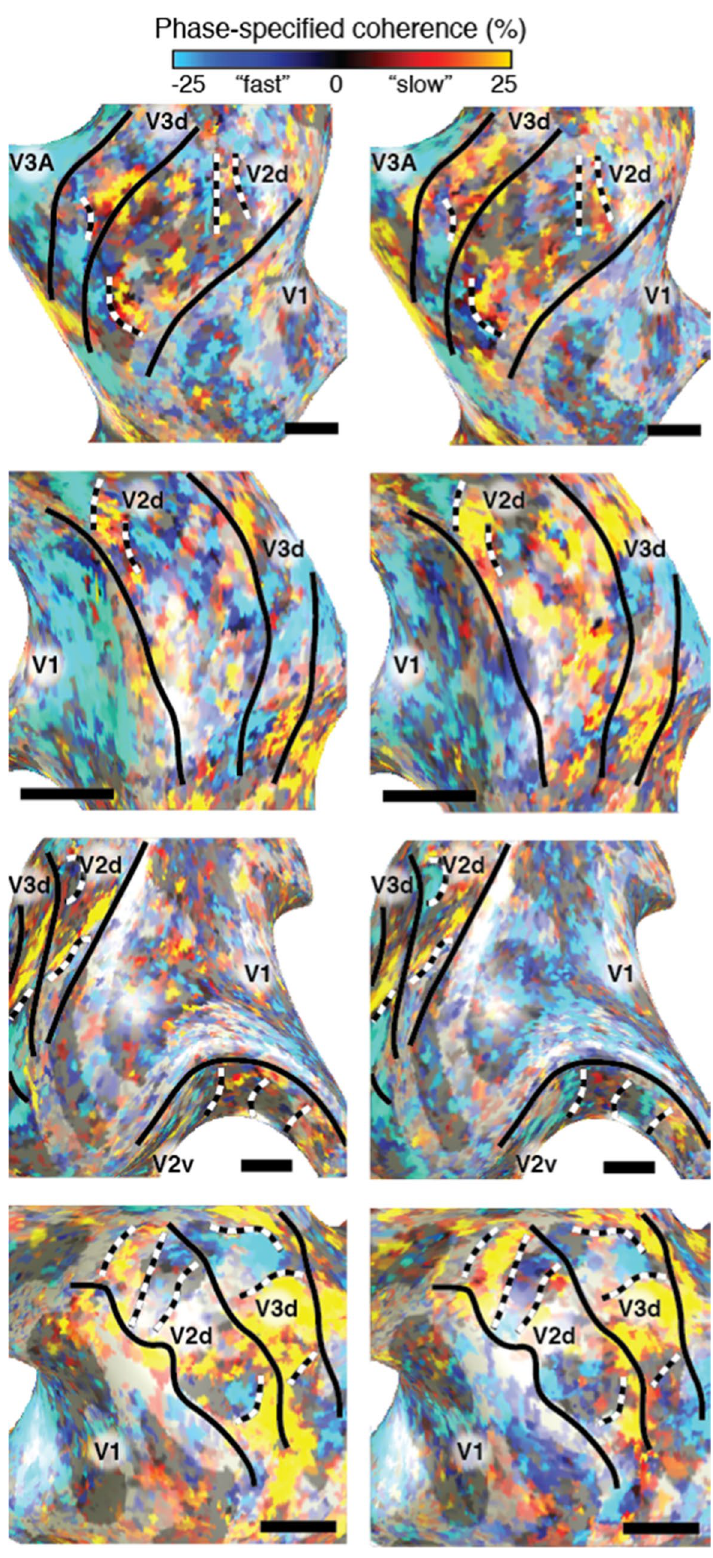
Figure 2. Independent functional delineation of V2 and V3 stripe-based subdivisions. Phase-specified coherence responses displayed on inflated cortical surfaces of the same subjects and in an identical fashion of Fig. 1 (left = odd runs and right = even runs). There is a significant correlation between these independent datasets. Black and white dashed lines illustrate correspondence between odd and even